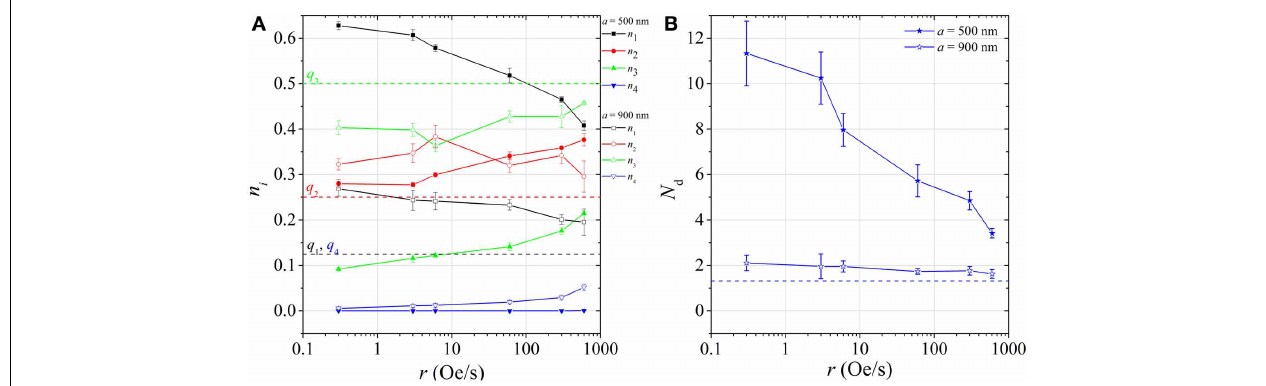
FIGURE 6 | (A) Vertex populations n i vs. ramping rate r for samples with a = 500nm (filled symbols) and a = 900nm (open symbols). (B) The corresponding average domain size N d . Dashed lines represent the limiting random-state